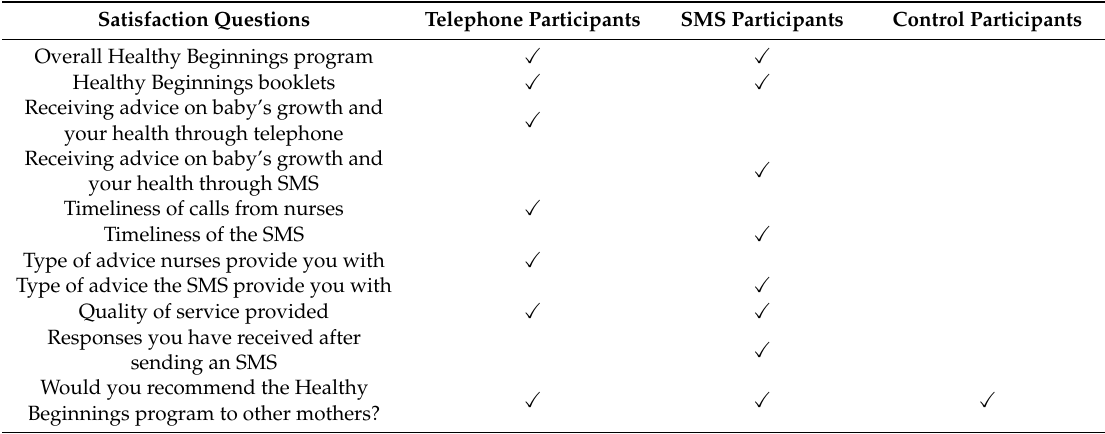
Table 1. Satisfaction questions administered at the six-month quantitative